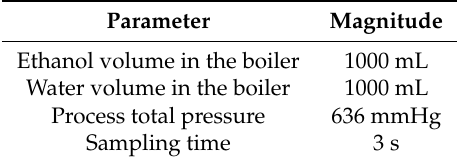
Table 4. Initial parameters of the distillation